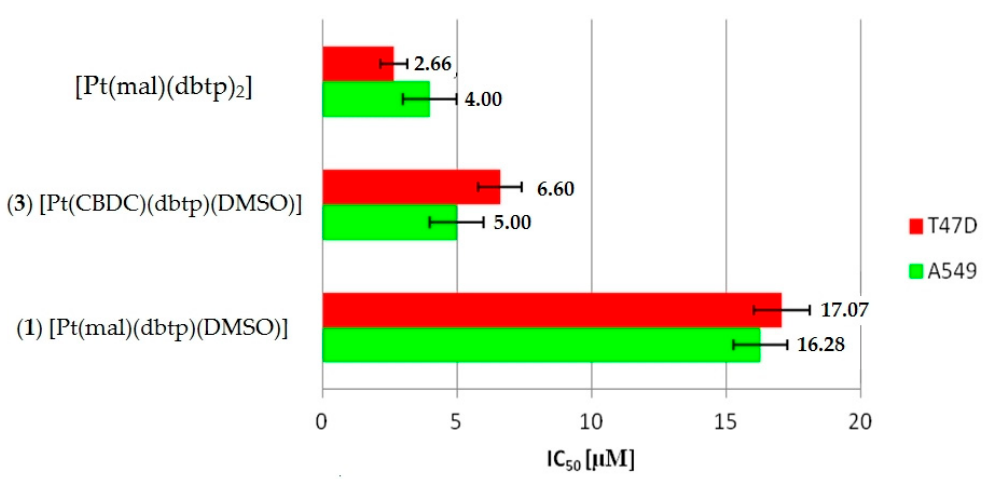
Figure 5. Influences of carrier ligand and leaving group on in vitro cytotoxicity.